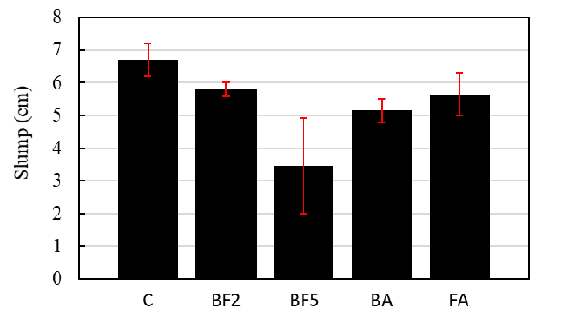
Figure 3. Slump test results.